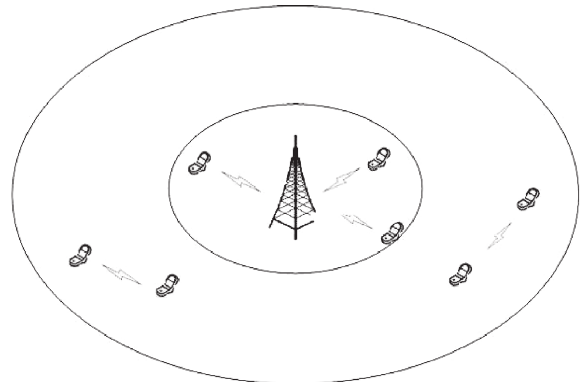
Figure 1: D2D underlay communication